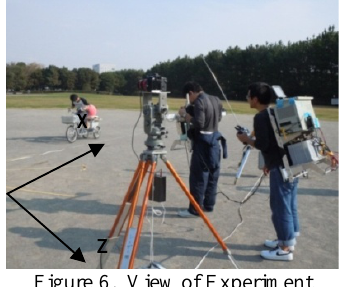
Figure 6. View of Experiment